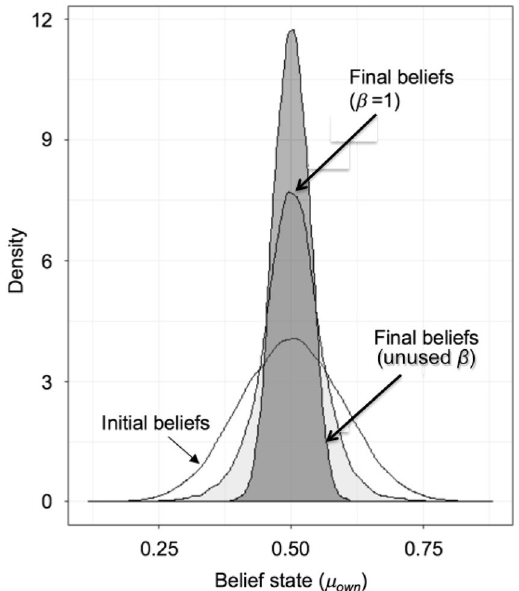
Figure 1. The distribution of beliefs (value of µ for each agent) shown for three cases of the random social structure model, with α = 1: (i) initial distribution at time zero; (ii) final beliefs (at time 200) when β = 1.0; (iii) final beliefs when β is unused (i.e. search is based solely on α = 1).